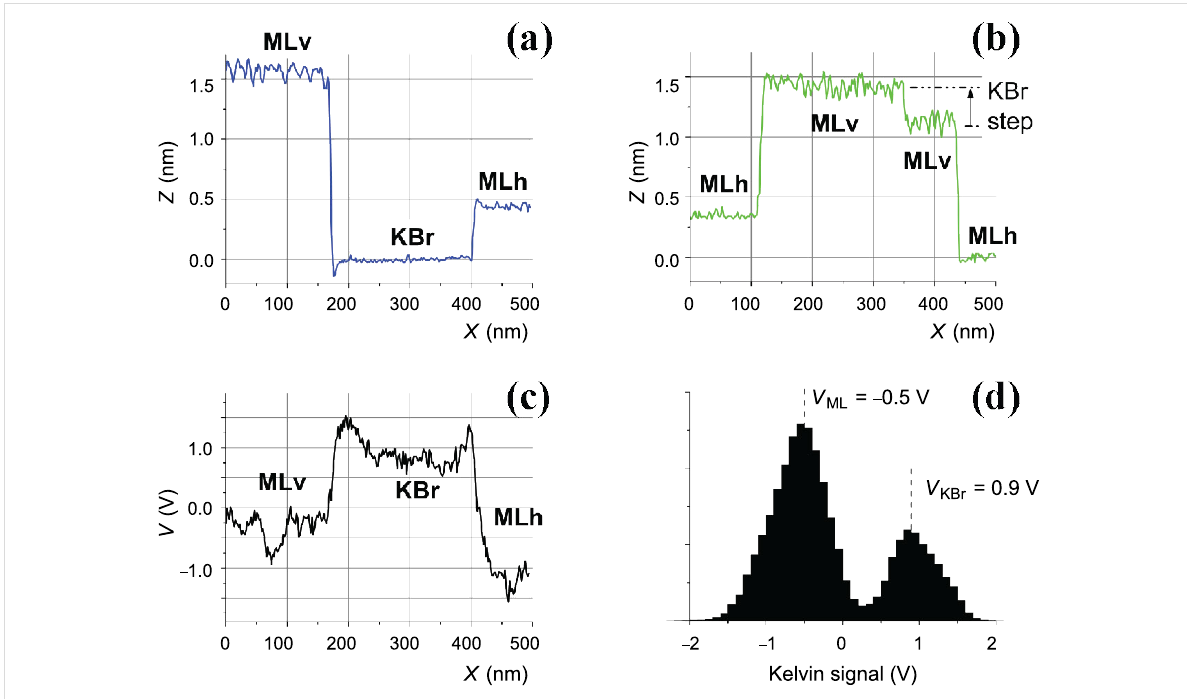
Figure 5: (a) and (b) are the profiles that correspond to the blue and green lines drawn in Figure 4a; (c) is the profile corresponding to the black line on Figure 4e, and (d) is the histogram of Figure 4e.